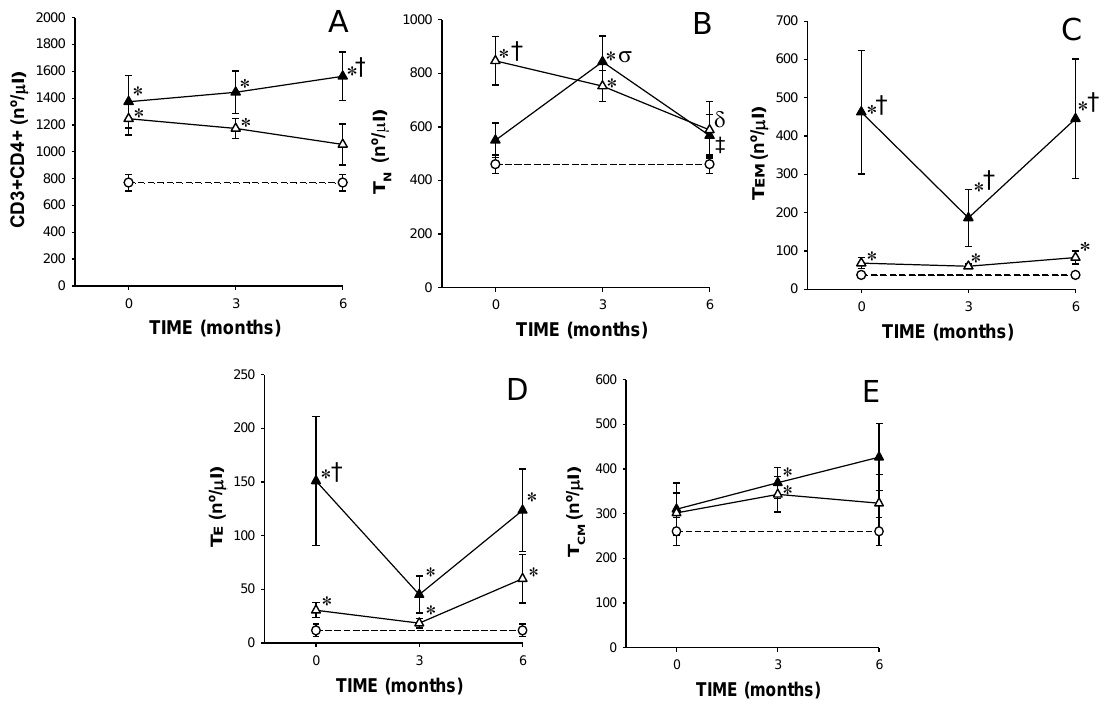
Figure 2. Panels A–E represents total and activation / di ff erentiation stage subsets of CD4 + T lymphocytes Figure 2. Panels A – E represents total and activation/differentiation stage subsets of CD4+ T Figure 2. Panels A – E represents total and activation/differentiation stage subsets of CD4+ T Figure 2. Panels A – E represents total and activation/differentiation stage subsets of CD4+ T Figure 2. Panels A – E represents total and activation/differentiation stage subsets of CD4+ T in eventual responders and non-responders at baseline, and between responders and non-responders lymphocytes in eventual responders and non-responders at baseline, and between responders and lymphocytes in eventual responders and non-responders at baseline, and between responders and lymphocytes in eventual responders and non-responders at baseline, and between responders and lymphocytes in eventual responders and non-responders at baseline, and between responders and after 3 and 6 months of treatment. Note . Values represent numbers of naïve (T N ), e ff ector memory non-responders after 3 and 6 months of treatment. Note . Values represent numbers of naïve ( T N ), non-responders after 3 and 6 months of treatment. Note . Values represent numbers of naïve ( T N ), non-responders after 3 and 6 months of treatment. Note . Values represent numbers of naïve ( T N ), non-responders after 3 and 6 months of treatment. Note . Values represent numbers of naïve ( T N ), effector memory (T EM ), effector (T E ) and central memory (T CM ) CD4 + T cells from ( )responders (T EM ), e ff ector (T E ) and central memory (T CM ) CD4 + T cells from ( effector memory (T EM ), effector (T E ) and central memory (T CM ) CD4 + T cells from ( )responders effector memory (T EM ), effector (T E ) and central memory (T CM ) CD4 + T cells from ( )responders effector memory (T EM ), effector (T E ) and central memory (T CM ) CD4 + T cells from ( )responders (including eventual at baseline) and ( )non-responders (including eventual at baseline) at up to 6 (including eventual at baseline) and ( )non-responders (including eventual at baseline) at up to 6 (including eventual at baseline) and ( )non-responders (including eventual at baseline) at up to 6 ) non-responders (including eventual at baseline) at up to 6 months of MTX treatment. (including eventual at baseline) and ( )non-responders (including eventual at baseline) at up to 6 months of MTX treatment. The dotted line represents the mean of the results obtained for each months of MTX treatment. The dotted line represents the mean of the results obtained for each months of MTX treatment. The dotted line represents the mean of the results obtained for each months of MTX treatment. The dotted line represents the mean of the results obtained for each variable in this group of subjects in the three different studies performed ( ). All values are variable in this group of subjects in the three different studies performed ( ). All values are variable in this group of subjects in the three different studies performed ( ). All values are ). All values are expressed as mean cell counts ± variable in this group of subjects in the three different studies performed ( ). All values are expressed as mean cell counts ± S.E.M. *, p < 0.05 for responders or non-responders (including expressed as mean cell counts ± S.E.M. *, p < 0.05 for responders or non-responders (including expressed as mean cell counts ± S.E.M. *, p < 0.05 for responders or non-responders (including expressed as mean cell counts ± S.E.M. *, p < 0.05 for responders or non-responders (including eventual) vs. healthy controls; †, p < 0.05 for responders vs. non-responders (including eventual), σ , p eventual) vs. healthy controls; †, p < 0.05 for responders vs. non-responders (including eventual), σ , p eventual) vs. healthy controls; †, p < 0.05 for responders vs. non-responders (including eventual), σ , p eventual) vs. healthy controls; †, p < 0.05 for responders vs. non-responders (including eventual), σ , p < 0.05 for values at 3 months of treatment compared to baseline, ‡, p < 0.05 at 6 months of treatment < 0.05 for values at 3 months of treatment compared to baseline, ‡, p < 0.05 at 6 months of treatment < 0.05 for values at 3 months of treatment compared to baseline, ‡, p < 0.05 at 6 months of treatment < 0.05 for values at 3 months of treatment compared to baseline, ‡, p < 0.05 at 6 months of treatment time compared to 3 months, and δ , p < 0.05 at 6 months of treatment time compared to baseline. time compared to 3 months, and δ , p < 0.05 at 6 months of treatment time compared to baseline. time compared to 3 months, and δ , p < 0.05 at 6 months of treatment time compared to baseline. A representative dot plot of CD4+ T lymphocytes and their activation/differentiation stages A representative dot plot of CD4+ T lymphocytes and their activation/differentiation stages A representative dot plot of CD4+ T lymphocytes and their activation/differentiation stages expression from RA responder and non-responder patients at baseline and HCs is shown in Figure expression from RA responder and non-responder patients at baseline and HCs is shown in Figure expression from RA responder and non-responder patients at baseline and HCs is shown in Figure 3. 3. 3.